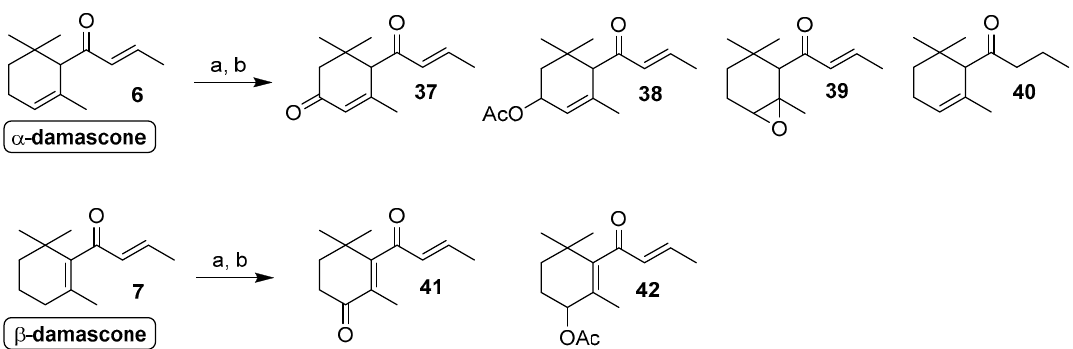
Figure 4. Compounds obtained through biotransformation of α - and β -damascone by means of the fungal strains employed in the present study. Reagents and conditions : ( a ) fungal strain, MEM, aerobic conditions, 140 rpm, 20–25 °C, 14–20 days; ( b ) Ac 2 O/Py, DMAP catalyst, rt, 6 h.